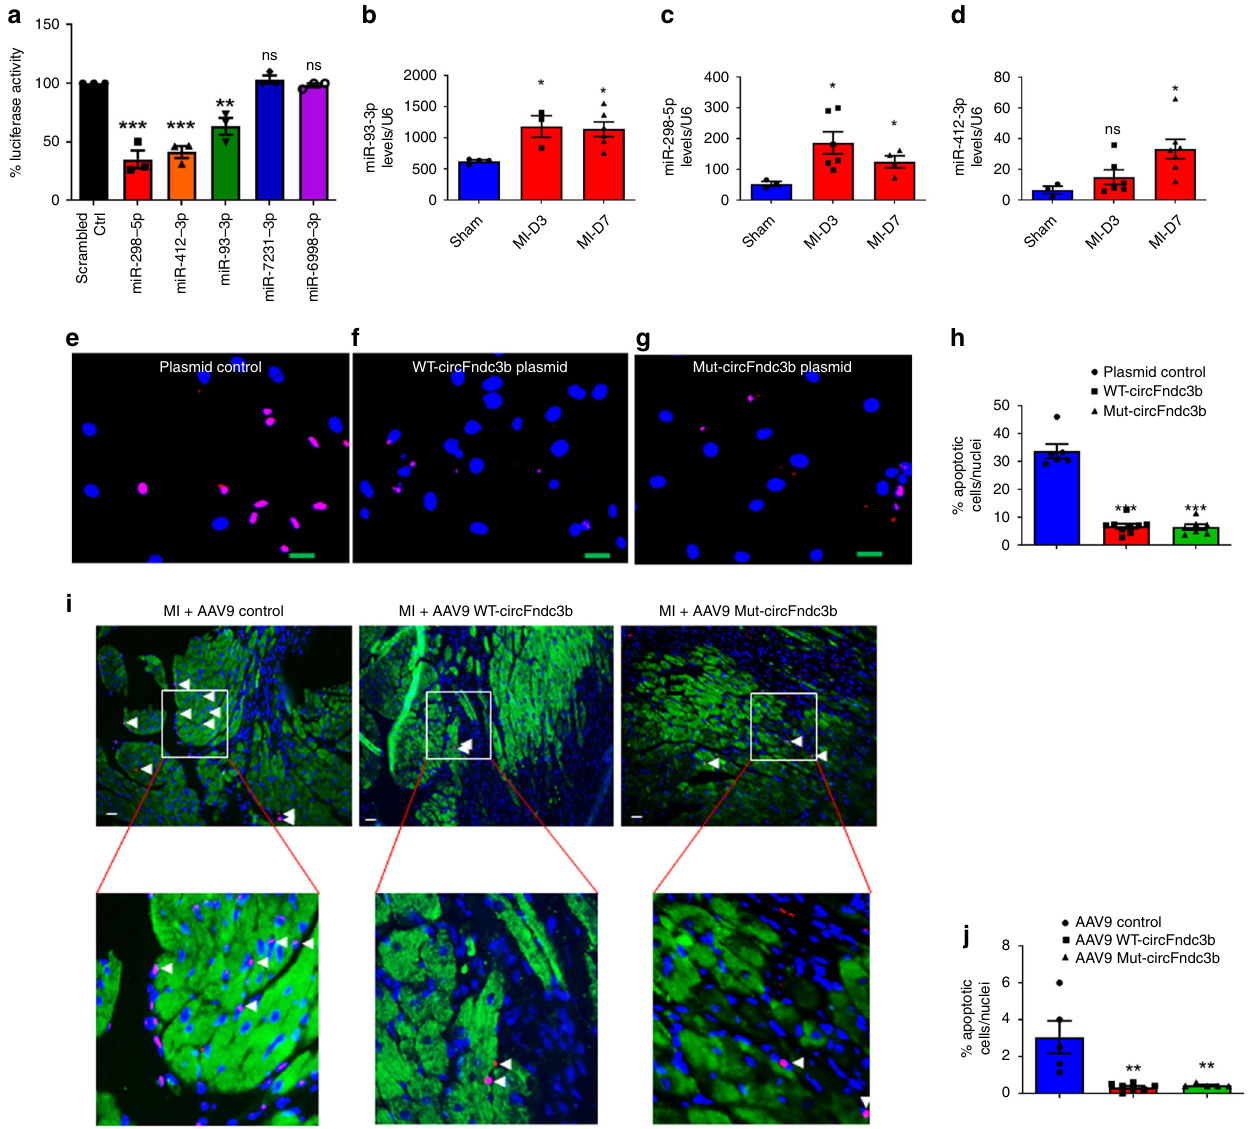
Fig. 6 miRNA binding sites are not critical for circFndc3b function: a CircFndc3b sequence was cloned into the 3 ′ UTR of the pGL3 Luciferase reporter to construct LUC-circFndc3b. MCECs were co-transfected with LUC-circFndc3b and different miRNA mimics (30 nM). Luciferase activity was detected using the dual luciferase assay at 48 h post transfection. Data are Mean± SEM of 3 independent experiments, ** P < 0.01 *** p < 0.001 vs scrambled control group (one-way ANOVA); b – d RT-qPCR analysis of circFndc3b target miRNAs (miR-93-3p, miR-298-5p and miR-412-3p) in 3 and 7 days post-MI hearts compared to sham, data normalized to U6 snRNA; Data are Mean ± SEM of n = 3 – 5/group. * p < 0.05 vs sham hearts (one-way ANOVA); e – g Representative images of H9c2 cells (Scale bar 20 μ m) treated with control plasmid or WT-circFndc3b or Mut-circFndc3b plasmids and subjected to hypoxic stress (1% O 2 , 48 h). TUNEL assay was performed; h Quanti fi cation of TUNEL + cells presented as the % TUNEL + positive cells and DAPI-stained nuclei. Data are Mean± SEM of 6 independent experiments. *** p < 0.001 vs control plasmid (one-way ANOVA); i , j Representative images and quanti fi cation of apoptotic cardiomyocytes in the myocardium at 10 days after MI in AAV9 control or AAV9 WT-circFndc3b or Mut-circFndc3b administered mice. TUNEL staining for detecting apoptosis (red) of cardiomyocytes ( α -SA, green fl orescence) and DAPI (blue) for nuclear staining. Arrows indicate TUNEL and α -SA + cells (Scale bar 100 μ m). n = 3/each group. *** p < 0.001 vs AAV9 control (two-sided unpaired students t